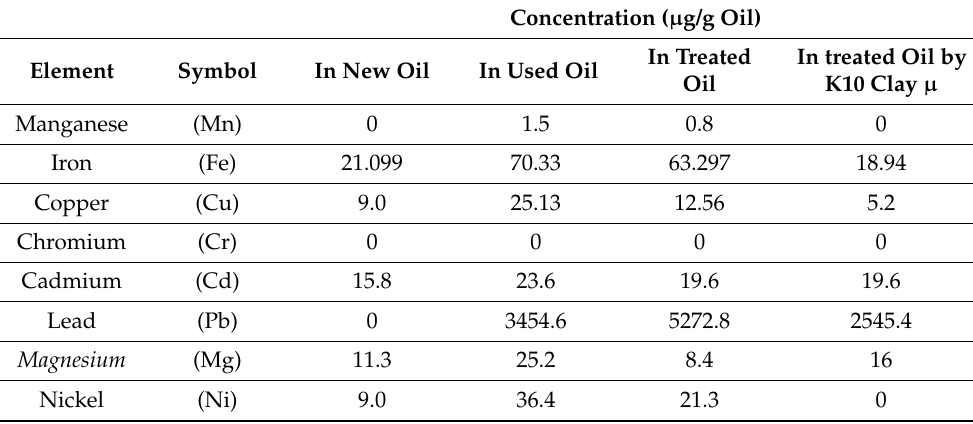
Table 3. Results of metal analysis of atomic absorption spectrometer